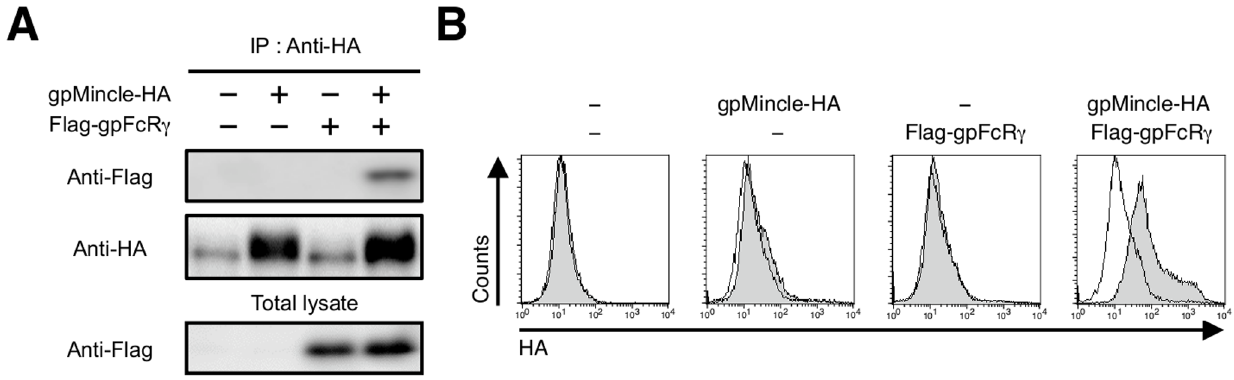
Figure 3. gpMincle is associated with FcR c . (A) Interaction of gpMincle with gpFcR c . HEK293T cells were transfected with HA-tagged gpMincle alone or together with Flag-tagged gpFcR c Total lysates were immunoprecipitated with anti-HA mAb and blotted with anti-Flag and anti-HA polyclonal antibodies (pAbs). Total lysates were also blotted with anti-Flag pAb. (B) Surface expression of gpMincle. HEK293T cells were transfected with gpMincle-HA alone or together with Flag-gpFcR c . Surface expression of gpMincle was detected by anti-HA pAb. Data are presented as representative of two separate experiments.